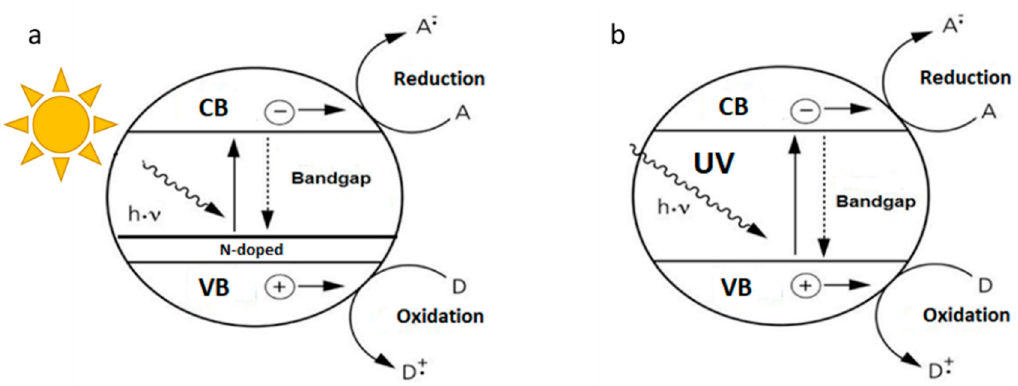
Figure 1. Explanation for the band-gap reduction for ( a ) N–TiO 2 when compared with undoped ( b ) TiO 2 .